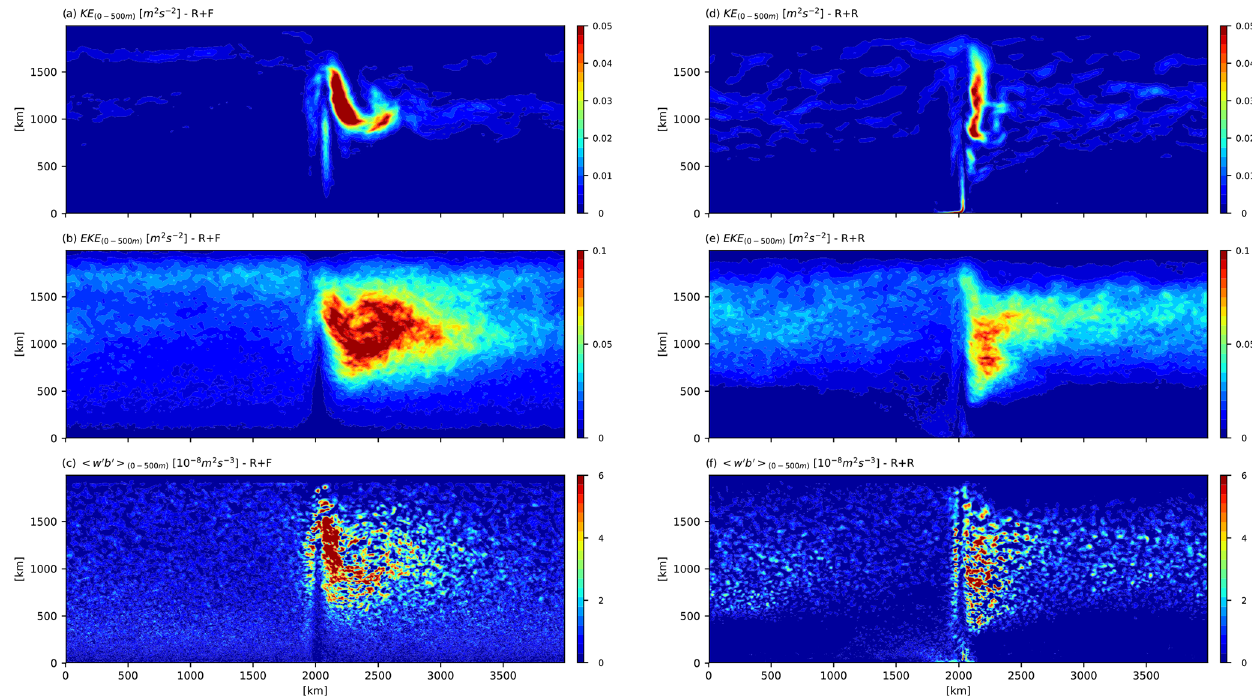
Figure 3. KE (m 2 s − 2 ) , EKE (m 2 s − 2 ) and < w (cid:48) b (cid:48) > (m 2 s − 3 ) averaged between the surface and 500m. These fields have been computed using instantaneous monthly data for the last 10 years of the simulation (a–c) R + F and (e–f) R + R.